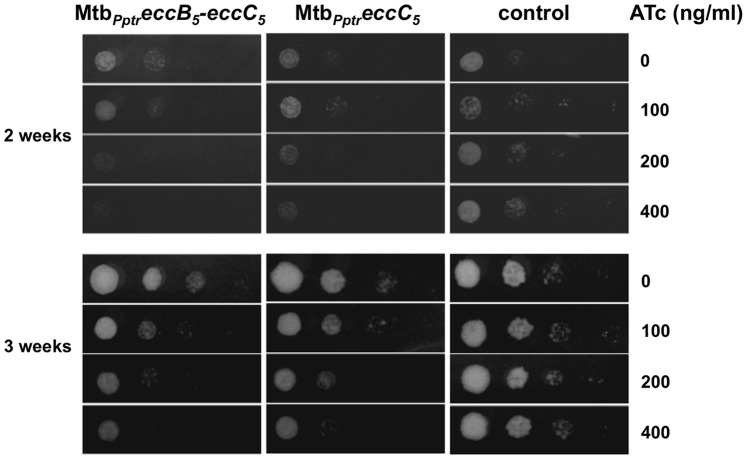
Growth of MtbPptreccB5-eccC5 and MtbPptreccC5 strains on solid medium.Ten-fold serial dilutions of cultures from MtbPptreccB5-eccC5, MtbPptreccC5 and M. tuberculosis control strain (Mtb::tetR-pip) were plated on Middlebrook 7H11, containing different concentrations of ATc, ranging from 0 to 400 ng/ml. Bacterial growth was checked after 2 and 3 weeks of incubation at 37°C.